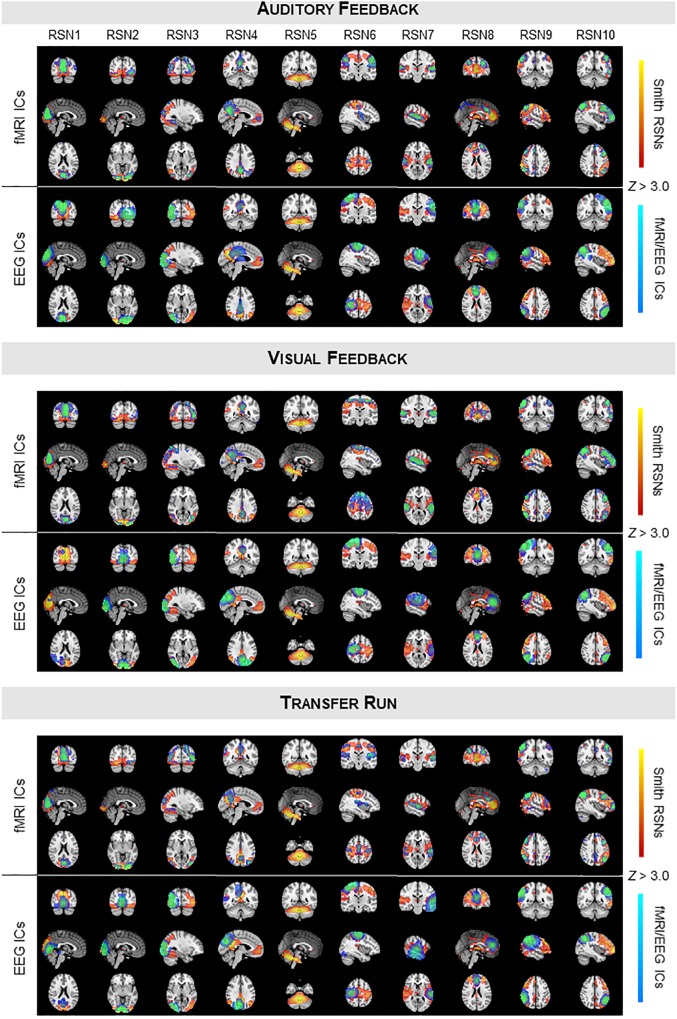
Group RSNs identified on fMRI and EEG-ESI data for the auditory feedback (top), visual feedback (middle), and transfer runs (bottom). For each run, the RSN templates (in red–yellow) from Smith et al. (2009) are superimposed with the fMRI (top) and EEG (middle) ICs (in blue–light blue) selected for each RSN template, according to their Dice coefficient.